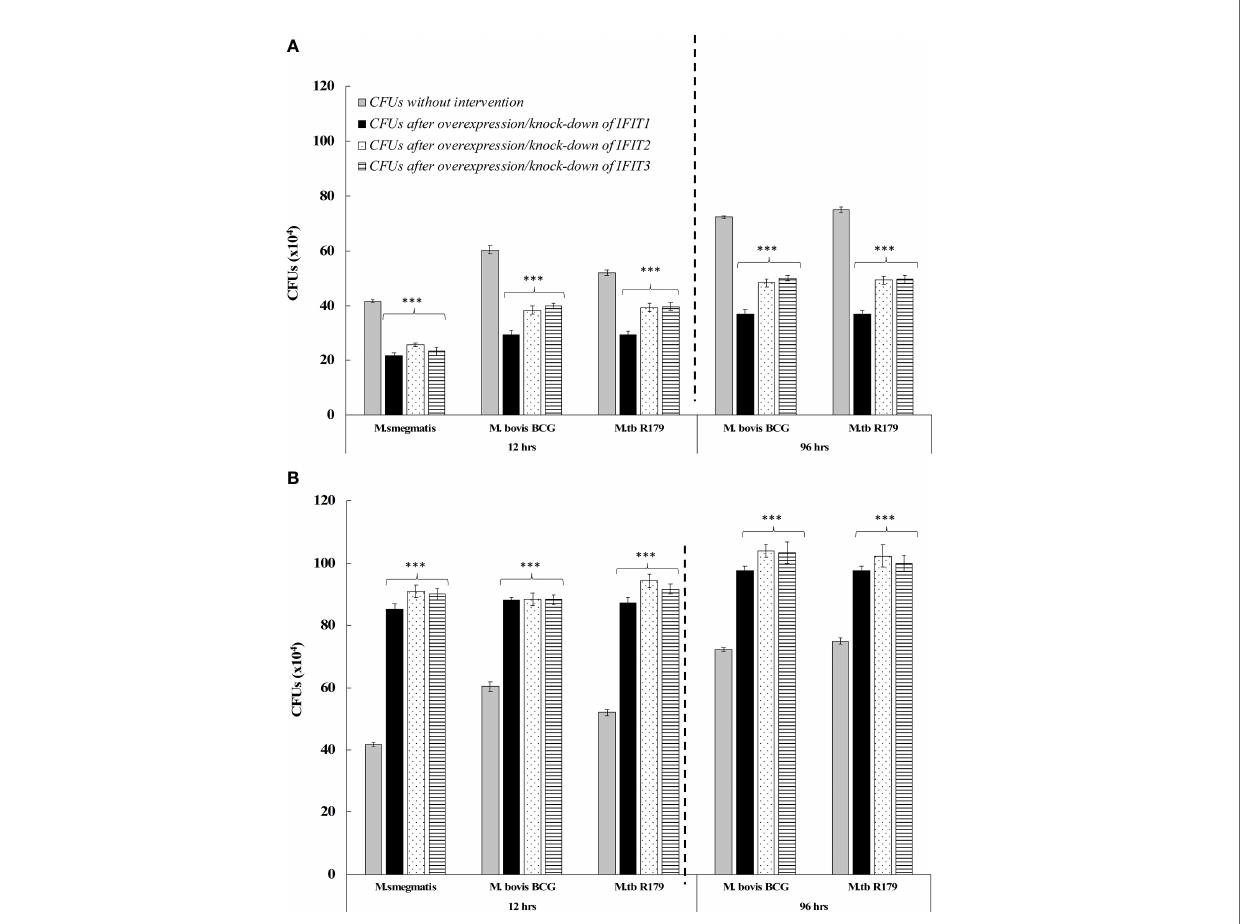
FIGURE 2 | Comparison of in vitro CFUs of M. bovis BCG after overexpression of IFITs at 12-hours and 96-hours (A) ; and knock-down of IFITs at 12-hours and 96-hours (B) . Compared to M. bovis BCG, we observed signi fi cant reduction of CFUs after overexpression of IFITs and signi fi cant increase of CFUs after knock- down of IFITs. The results indicate the association of IFITs with in vitro survival of Mycobacteria. BCG, Bacillus Calmette-Guerin; IFIT, interferon-induced protein with tetratricopeptide. Table 2 depicts the %-increase or decrease in CFUs after in vitro knock-down and overexpression respectively.